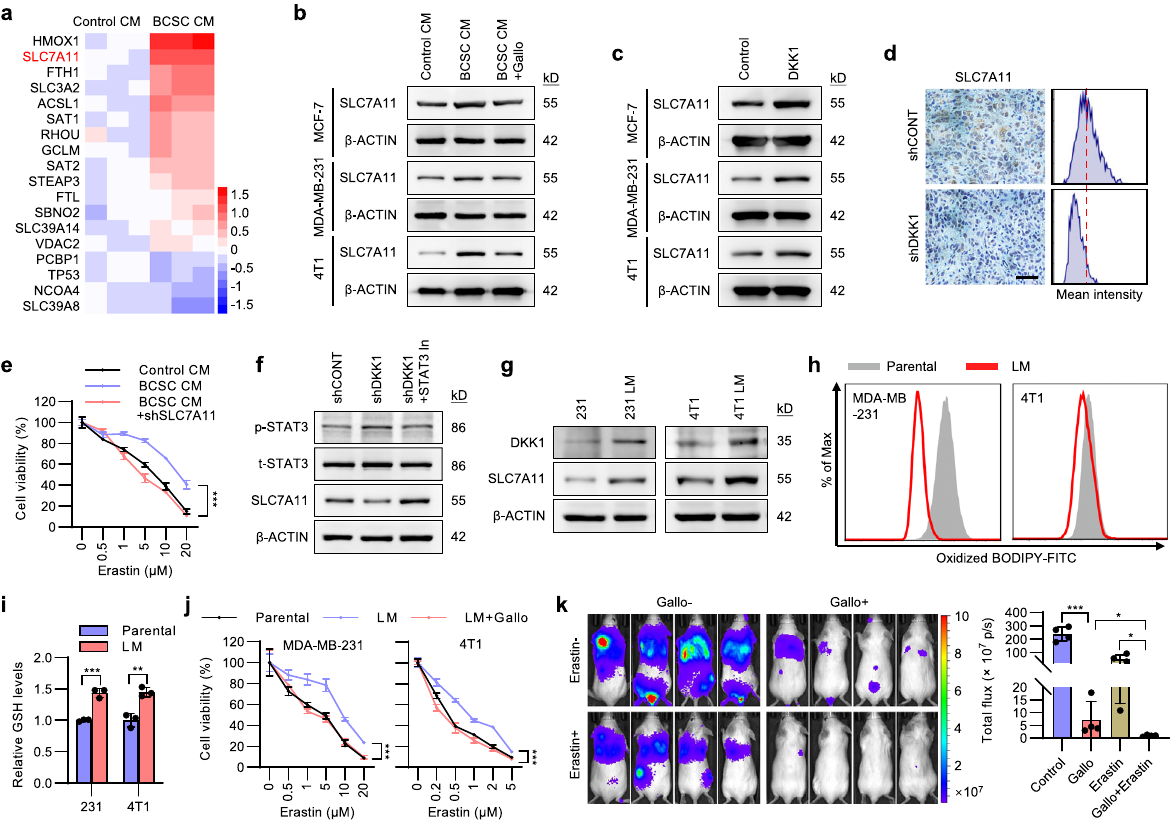
Fig. 6 DKK1 promotes SLC7A11 expression. a Heatmap represents the signi fi cantly altered ferroptosis related genes in MCF-7 cells cultured with CM from BCSCs or parental cells. b Immunoblot assessment of SLC7A11 protein levels. Cells were cultured with the CM obtained from respective parental cells or mammosphere-enriched BCSCs and treated with Gallocyanine (5 μ M) or vehicle. c Immunoblot assessment of SLC7A11 protein levels in cells treated with vehicle or 100 ng/ml DKK1. d IHC staining of SLC7A11 in lung metastases derived from MDA-MB-231-shCONT or -shDKK1 cells. Scale bar: 50 μ m. e Cell viability of MDA-MB-231-shCONT or -shSLC7A11 cells cultured with control CM or BCSC CM and treated with a graded concentration of Erastin for 48 h. f Immunoblot assessment of SLC7A11, phosphorylated and total STAT3 protein levels in MDA-MB-231-shCONT or -shDKK1 cells treated with or without 5 μ M STAT3 Inhibitor. g Immunoblot assessment of DKK1 and SLC7A11 protein levels in the indicated cells. h Lipid ROS levels in the indicated cells. i The relative GSH levels in the indicated cells. j Cell viability of the parental or lung metastasis derived MDA-MB-231 or 4T1 cells treated with Gallocyanine and a graded concentration of Erastin for 48 h. k BLI of mice intravenously injected with 1 × 10 5 4T1-luc cells. The mice were treated with Erastin, Gallocyanine or combined Erastin and Gallocyanine as indicated. Results are shown as mean ± S.D. * P < 0.05; ** P < 0.01; *** P < 0.001; ns not signi fi cant (Two-way ANOVA test in ( e , j ) others unpaired two-tailed Student ’ s t test). Source data are provided as a Source Data fi